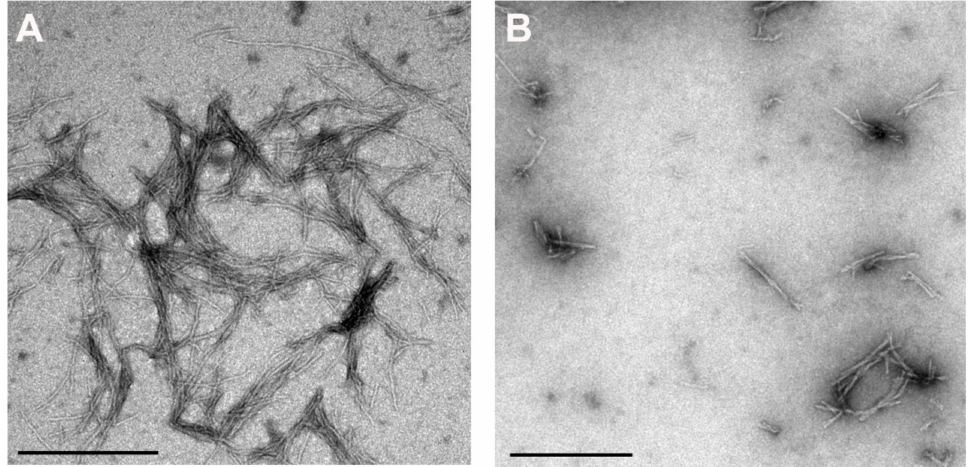
Figure 2. TEM images of stB fibrils at the plateau phase ( A ) alone or ( B ) at 50 µ M Cur + 0.5 mM vitC. Scale bars = 0.5 µ